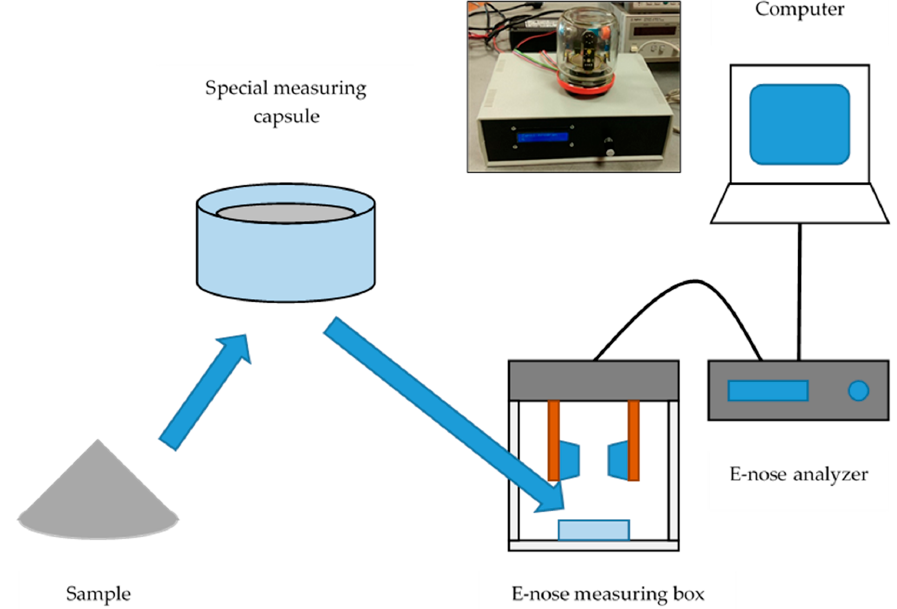
Figure 2. The schematic diagram of measuring dough leavening using a simple experimental electronic